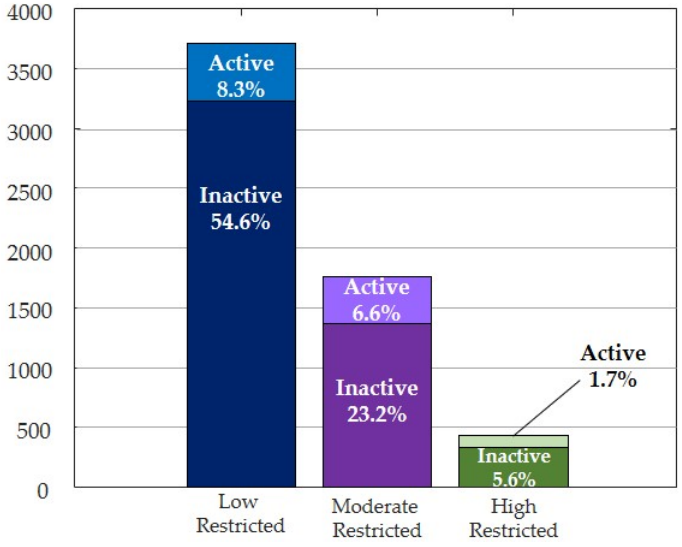
Figure 12. The ratio of clusters in the second stage